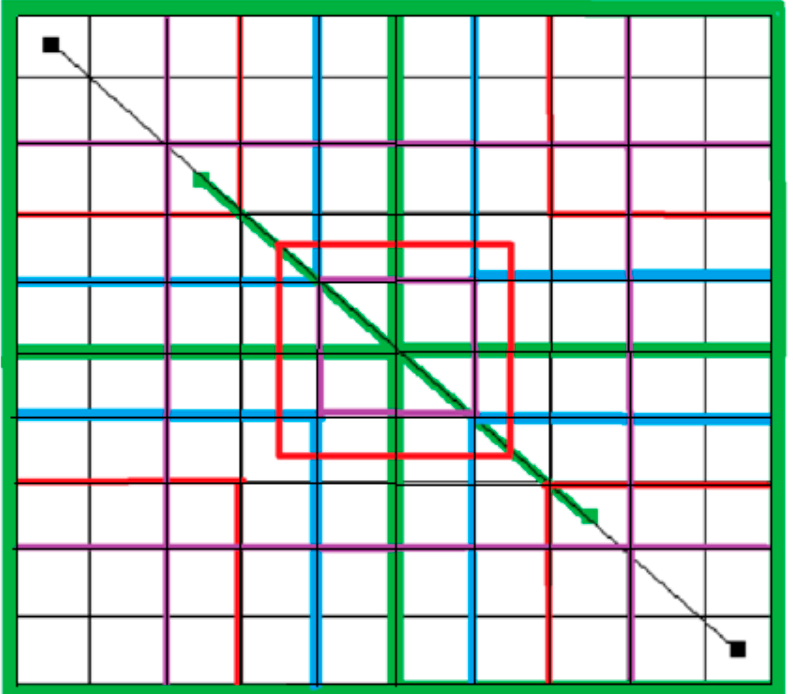
Figure 1. Sampling design. Each black square represents a 5 m × 5 m plot. The purple square represents a 10 m × 10 m plot; the red square represents a 15 m × 15 m plot; the blue square represents 20 m × 20 m plot; the green squares represent 25 m × 25 m plots. For 5 m × 5 m, 10 m × 10 m, 15 m × 15 m and 20 m × 20 m scales, not all side is exhibited here to avoid visual interference. The black plots represent the soil collection sites of the 5 m × 5 m plots, the green plots represent the soil collection sites of the 25 m × 25 m plots. The black straight line represents the farthest distance of a 5 m × 5 m plot-pair, and the green straight line represents the farthest distance of a 25 m × 25 m plot-pair.